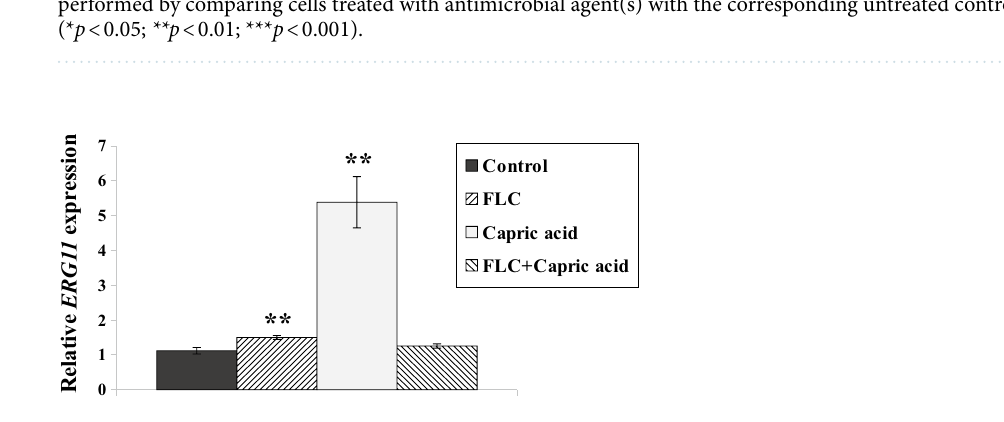
Figure 3. Relative ERG11 gene expression in the C. albicans CAF2-1 grown for 8 h in the following conditions: control without antimicrobial agents, FLC—treated with fluconazole 4 μg/mL; Capric acid—treated with capric acid 45.3 μg/mL; FLC + Capric acid—simultaneously treated with fluconazole 4 μg/mL and capric acid 45.3 μg/mL. Gene expression levels are reported as means ± SD of 2 −ΔΔCT values ( n = 3), normalized to 1 for control conditions. Statistical analysis was performed by comparing the ERG11 expression level of cells treated with antimicrobial agent(s) with the corresponding untreated control. Statistical significance was presented as follows: ** p <